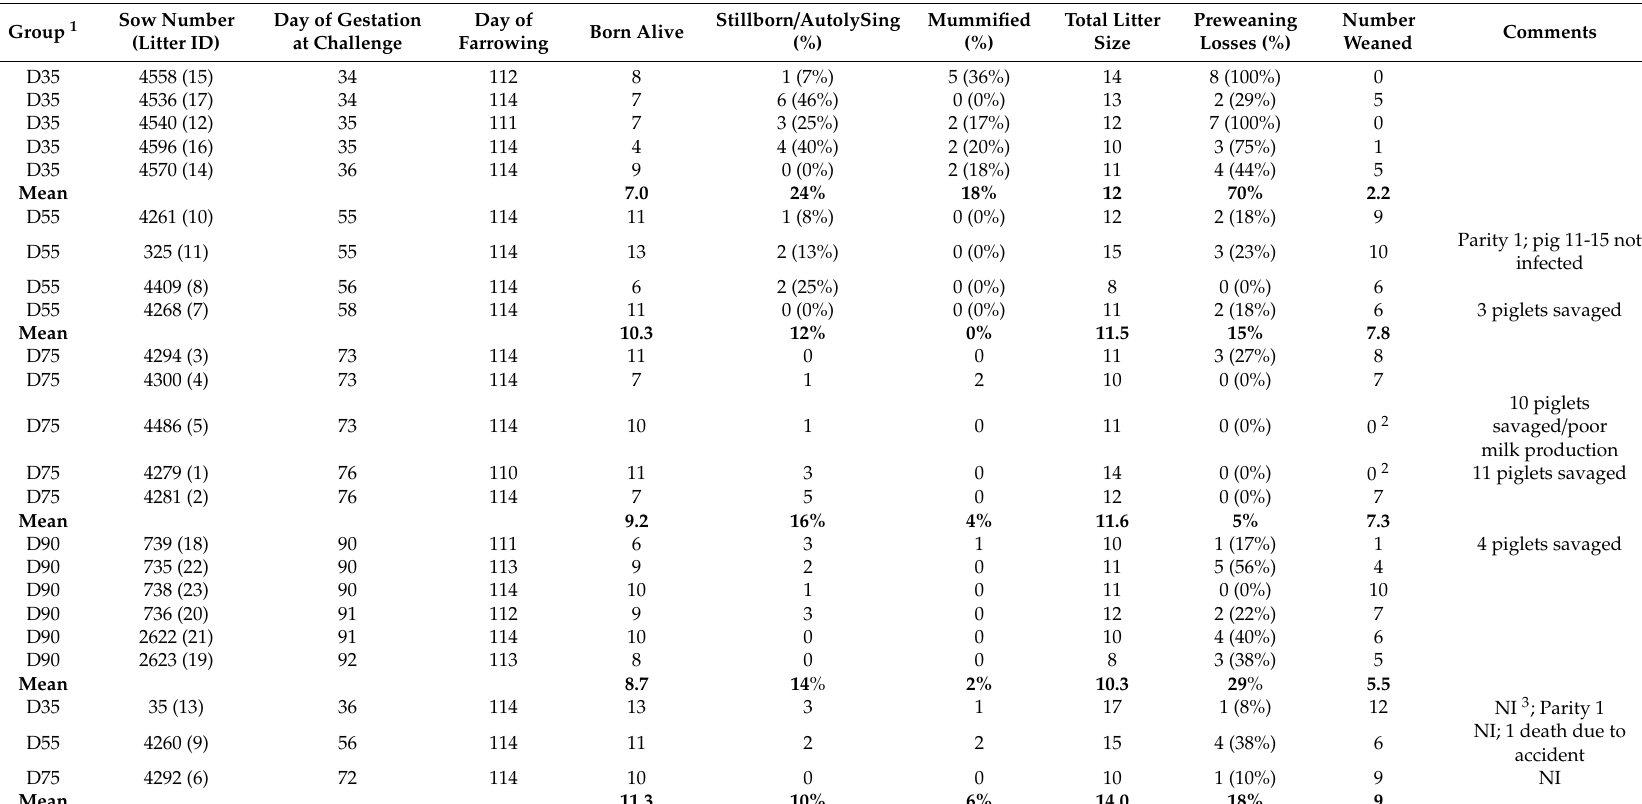
Table 1. Summary of challenge details and reproductive outcomes following the inoculation of pregnant pigs with Bungowannah virus. Group